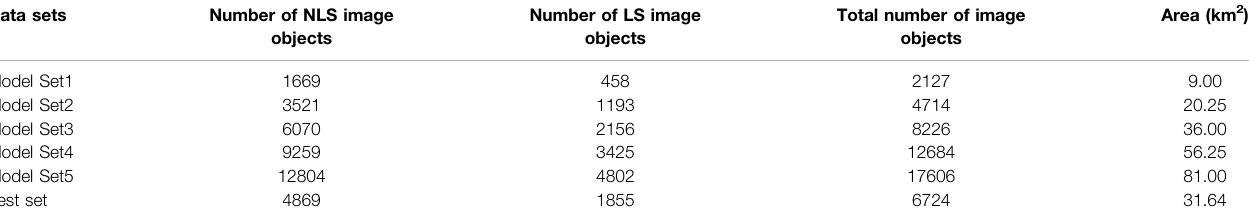
TABLE 4 | The number of Landslide (LS) and Non-Landslide (NLS) image objects labeled for the models and test datasets to be used in the analysis process. Data sets